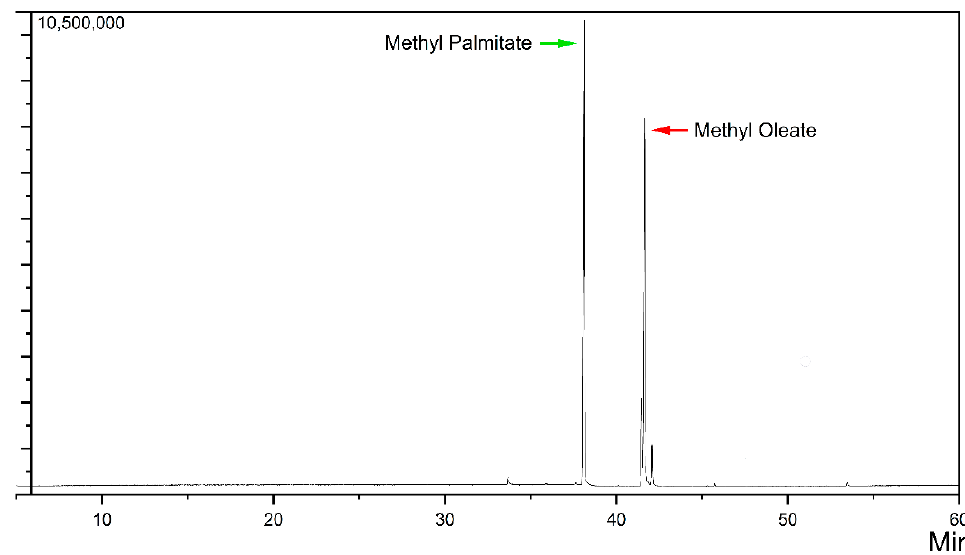
Figure 7. The GC chromatogram of the obtained biodiesel using CaO/PMFA-900-600.